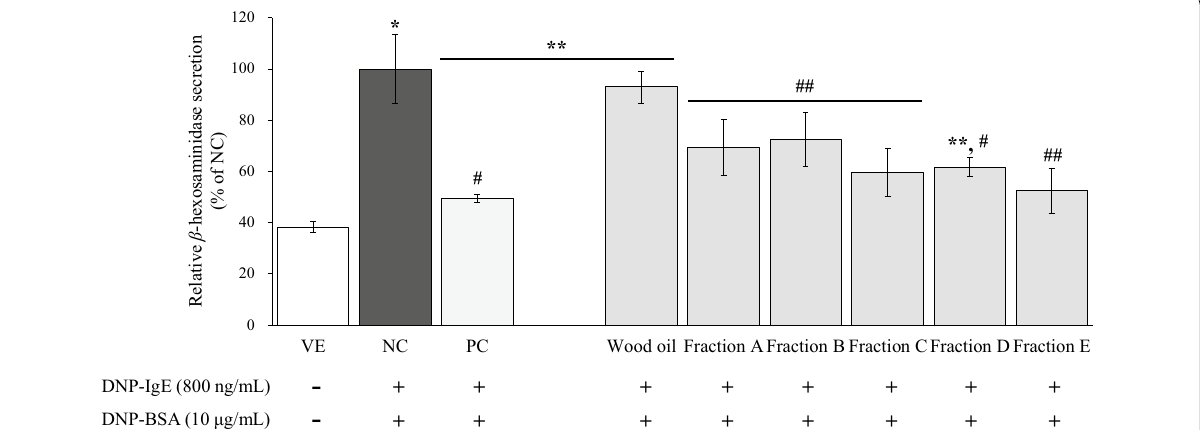
Fig. 5 Inhibitory effect of the wood essential oil and five oil fractions on β ‑hexosaminidase release. VE: vehicle, DMSO; NC: negative control, 800 ng/ mL DNP‑IgE and 10 μg/mL DNP‑BSA treated group; PC: positive control, 100 nM dexamethasone treated group, an oil fraction (A–F) (0.08 μg/mL). Values are presented as mean standard deviation. * p < 0.05 and ** p < 0.01 compared with VE; and # p < 0.05, ## p < 0.01 compared with ±